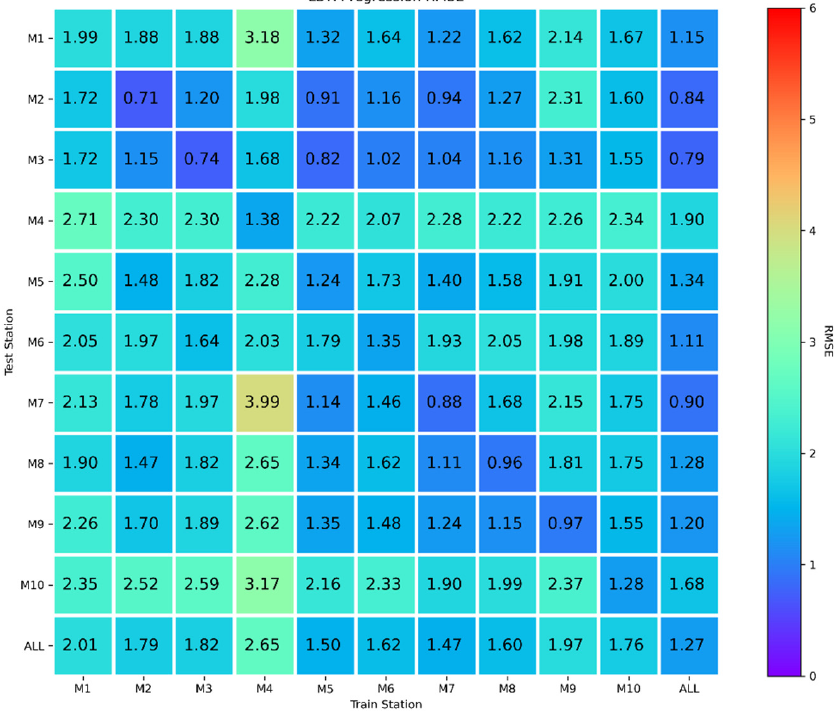
Figure 6. The RMSEs of results predicted by LSTM regression method with different training and test data.